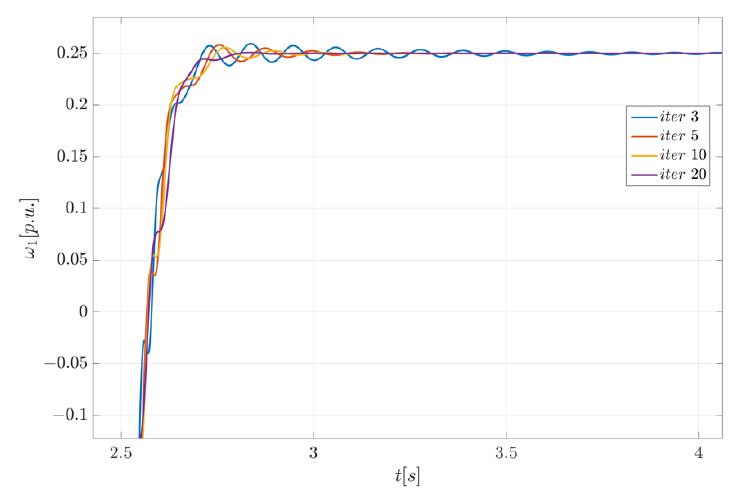
Figure 4. The Grey Wolf Optimizer.